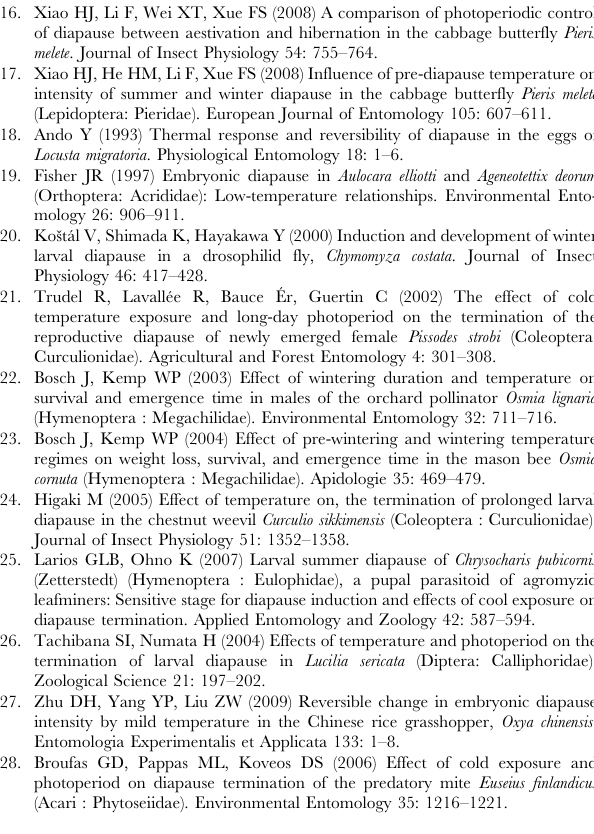
Values followed by different letters are significantly different by Bonferroni test (P , 0.05). (TIF) Figure S6 Cumulative eclosion in winter diapausing pupae of P. melete . The diapausing pupae were transferred to LD12.5:11.5 at 20 u C after exposure to 10 u C and DD for different days. The hatched bar indicates the period of cold exposure. Values followed by different letters are significantly different by Bonferroni test (P , 0.05). (TIF) Figure S7 Cumulative eclosion in winter diapausing pupae of P. melete . The diapausing pupae were transferred to LD12.5:11.5 at 20 u C after exposure to 15 u C and DD for different days. The hatched bar indicates the period of cold exposure. Values followed by different letters are significantly different by Bonferroni test (P , 0.05).